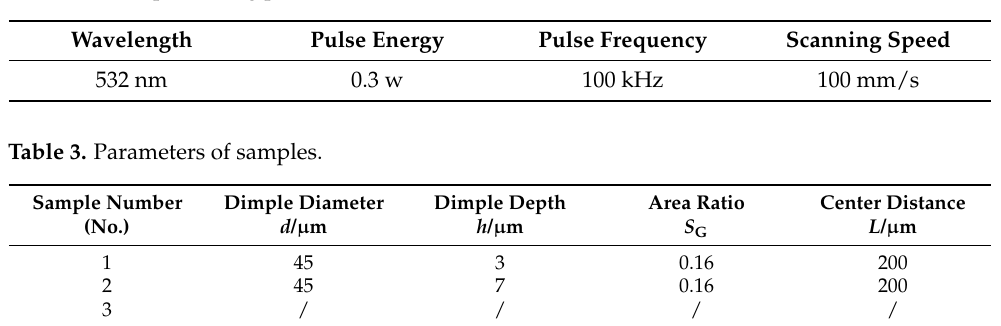
Table 1. Sample parameters. Table 2. Laser processing parameter.